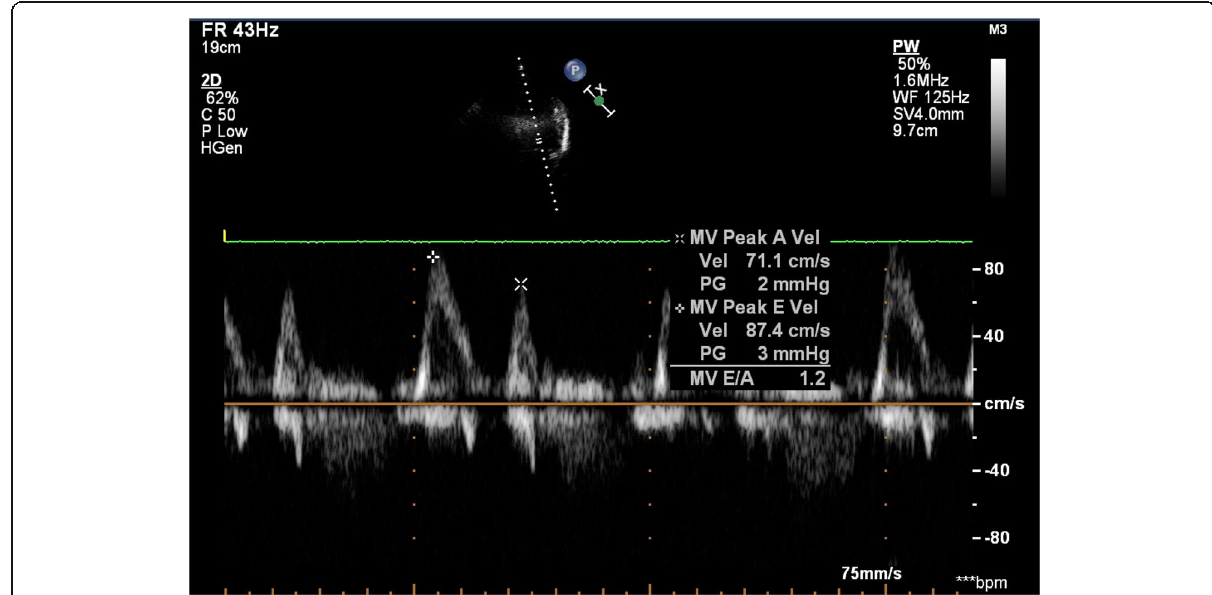
Fig. 3 Assessment of diastolic function by transmitral inflow pulsed wave Doppler study